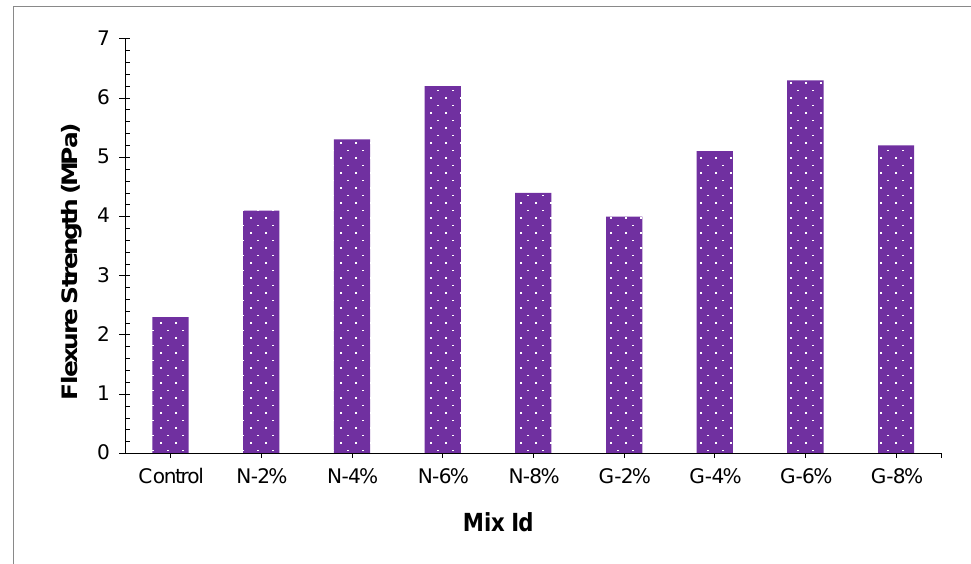
Figure 8. Split tensile strength of concrete.